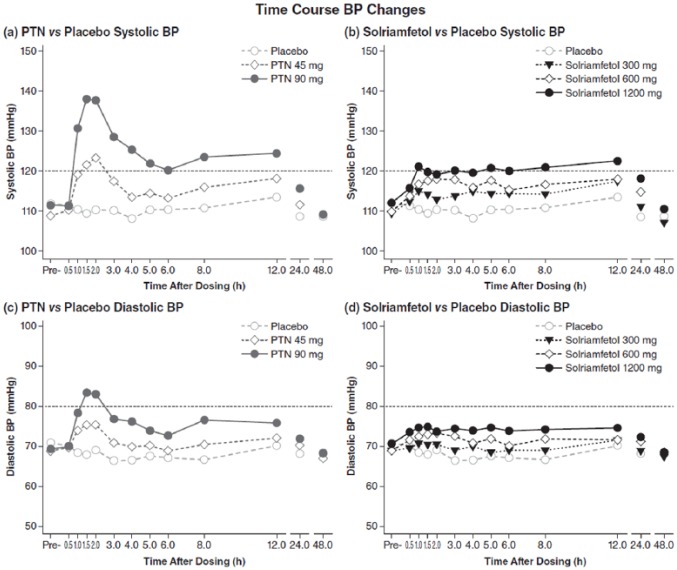
Time course of blood pressure changes after dosing. Dashed lines indicate
upper limits normal for systolic and diastolic pressure.BP: blood pressure; PTN: phentermine